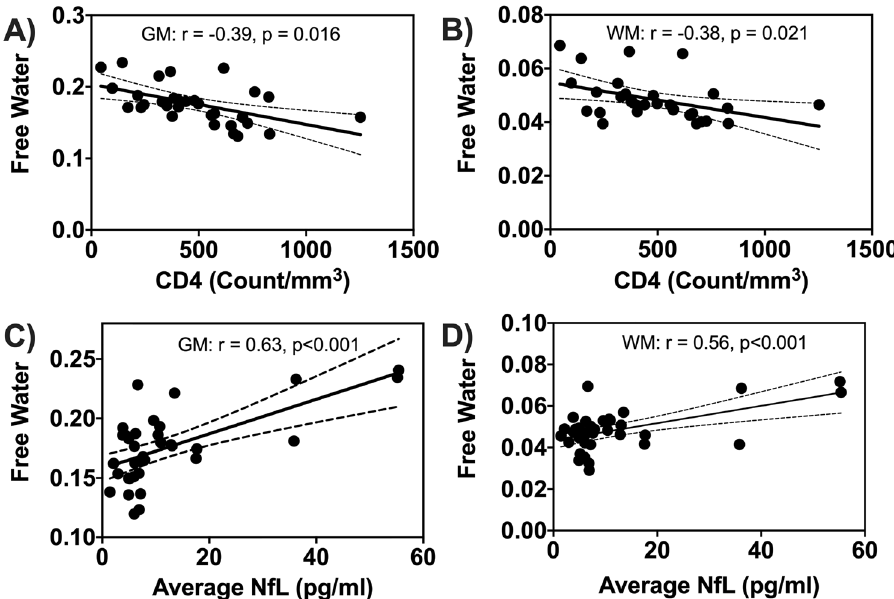
Figure 4. Baseline correlations between free water and blood markers. Scatter plots showing correlations between free water (FW) in grey matter (GM) and white matter (WM) with CD4 counts ( A , B) , and average neurofilament light chain (NfL) (C , D) . Solid black lines indicate linear fit and dashed lines are 95% confidence